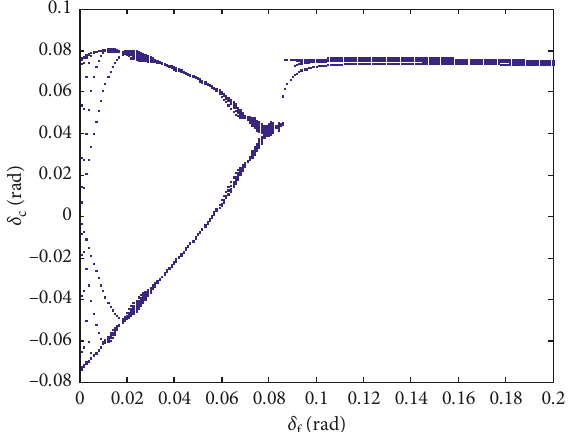
Figure 12: Phase diagram of the compliance steering angle when m